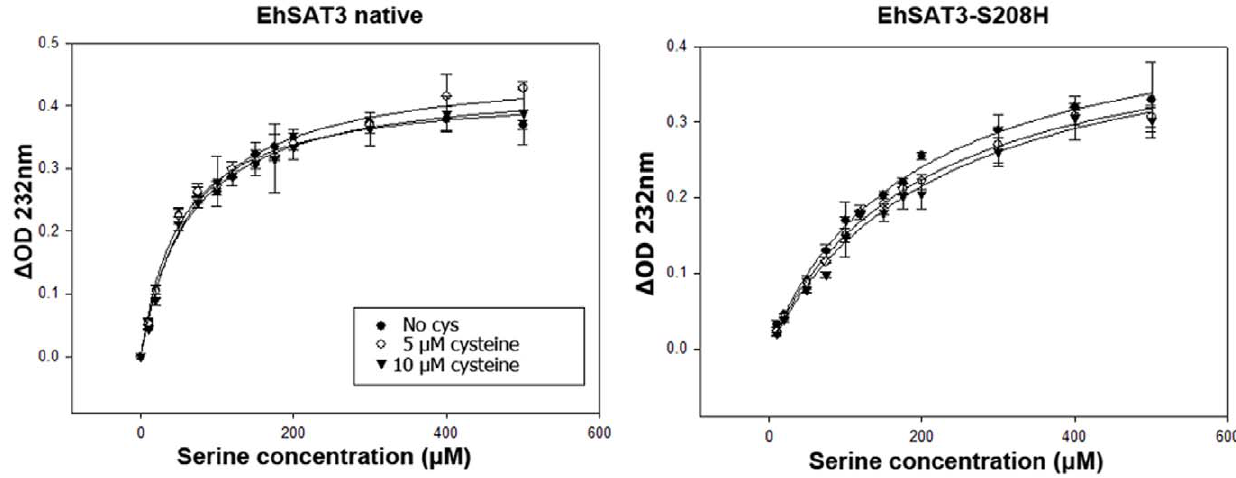
Figure 6. Kinetic study of EhSAT3. Michaelis Menten representation of velocity values plotted against the serine concentrations for EhSAT3 native and mutant (S208H). Kinetic studies were done in 50 mM Tris buffer pH 8.0 keeping acetyl CoA concentration constant at 0.1 mM and varying concentration of serine from 10 m M to 500 m M. The inhibition studies were done in presence of 5 m M and 10 m M of cysteine. K m was calculated by the Michaelis Menten equation using Sigma Plot software. Standard deviations are calculated from the three independent experiments for each substrate concentration values. EhSAT3 activity was not affected by the mutation but the mutant EhSAT3 show increased sensitiveness to cysteine